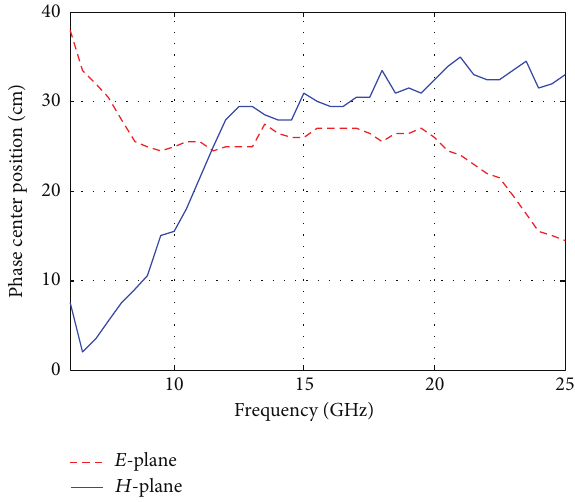
Figure 7: Variation of the phase center positions with frequency at E- and H